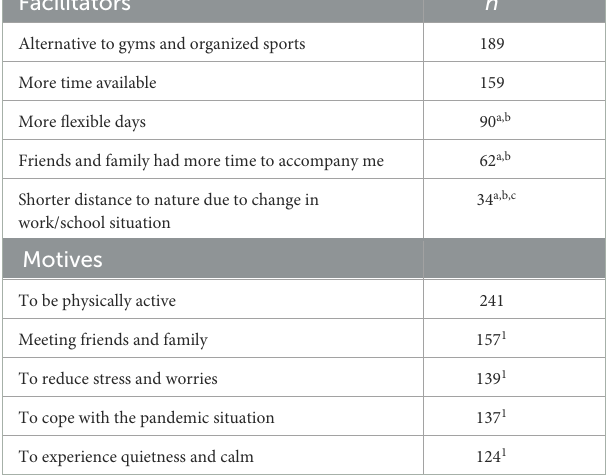
TABLE 4 Facilitators and motives for increased frequency among participants that increased their frequency of nature visits ( n = 324). Facilitators